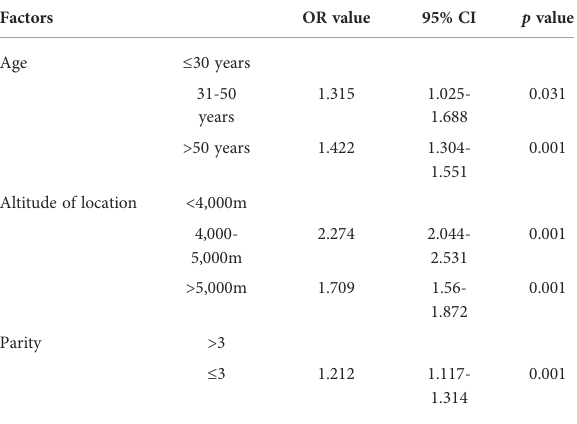
TABLE 4 Independent factors in fl uencing HPV infection in women of Nagqu. Factors